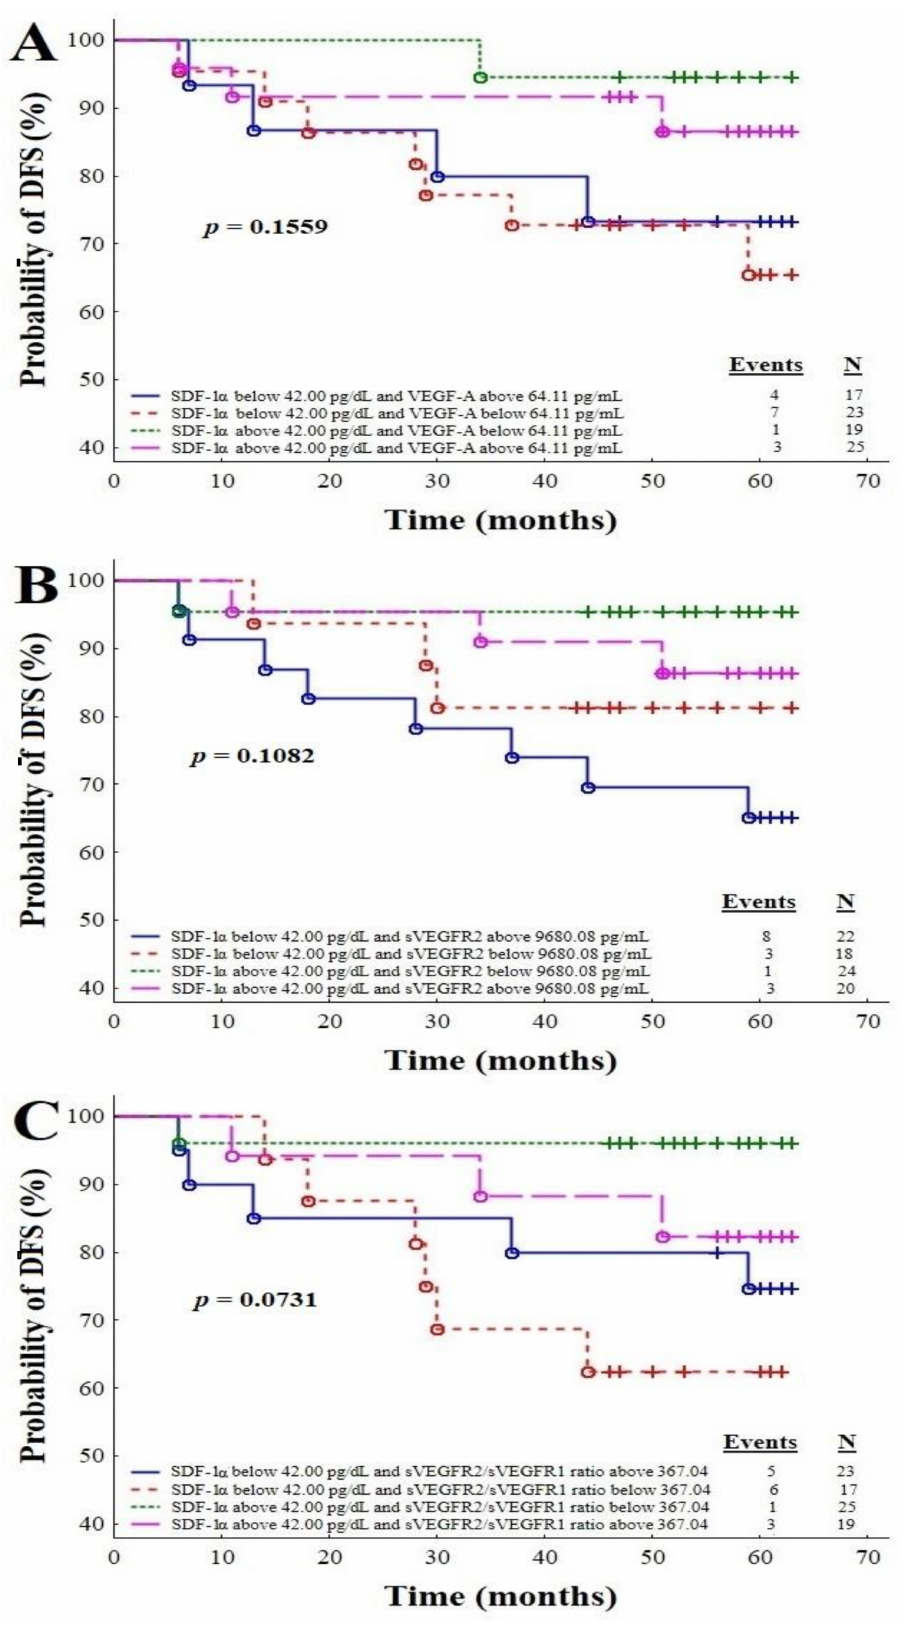
Figure 6. Plots A, B and C: Combinations of the SDF-1 α level and VEGF-A ( A ), the SDF-1 α level and sVEGFR2 ( B ), and the SDF-1 α level and sVEGFR2/ sVEGFR1 ratio ( C ) for the prediction of disease